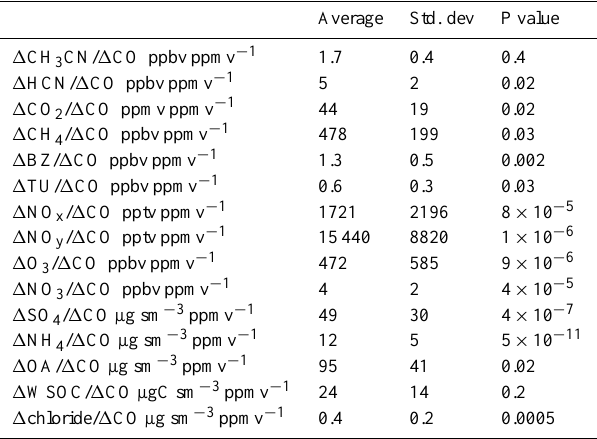
Table 3. Results of the statistical comparison of NEMRs of com- pounds in different